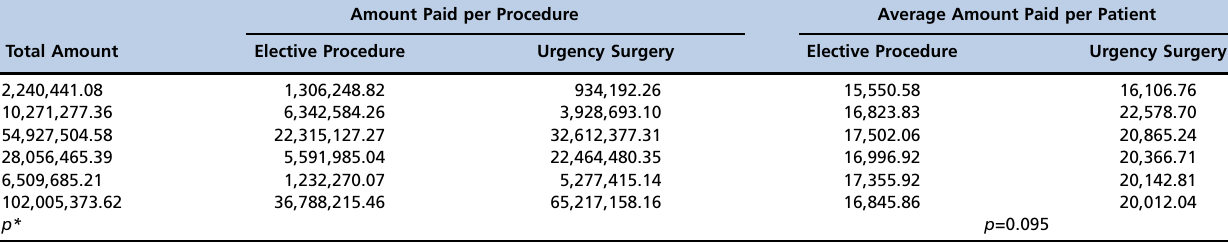
Table 3 - Values passed by SUS in Brazilian Reals per geographic region by procedure type.